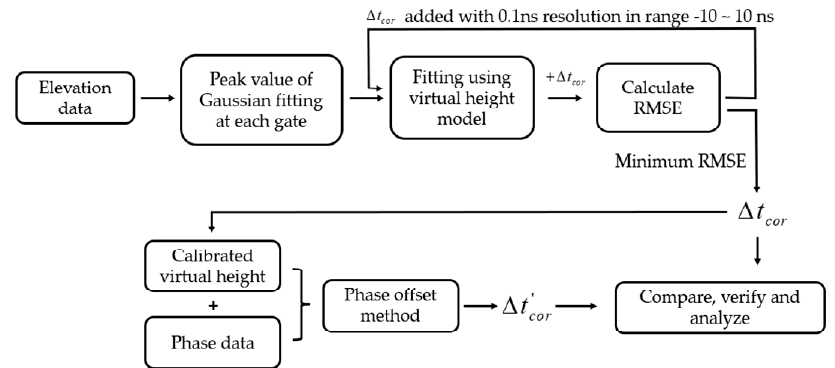
Figure 8. Flowchart of the main step of the proposed method.